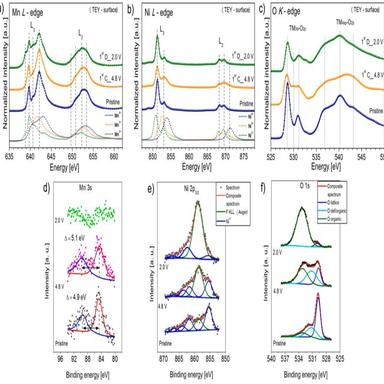
XAS spectra obtained in TEY (Total Electron Yield) mode of a) Mn and b) Ni L-edges and c) O K-edges as well as XPS spectra of d) Mn 3 s, e) Ni 2p3/2 and f) O 1 s for the pristine sample, charged to 4.8 V (1st C_4.8 V) and discharged to 2.0 (1st D_2.0 V) in initial cycle of Li/Li+/LiO2 cell. For the sake of comparison the visually imported XAS references to experimental spectra are shown as well: for Mn2+ (MnO), Mn3+ (Mn2O3), Mn4+ (MnO2) and the calculated spectra of Ni2+/Ni3+/Ni4+, done in a